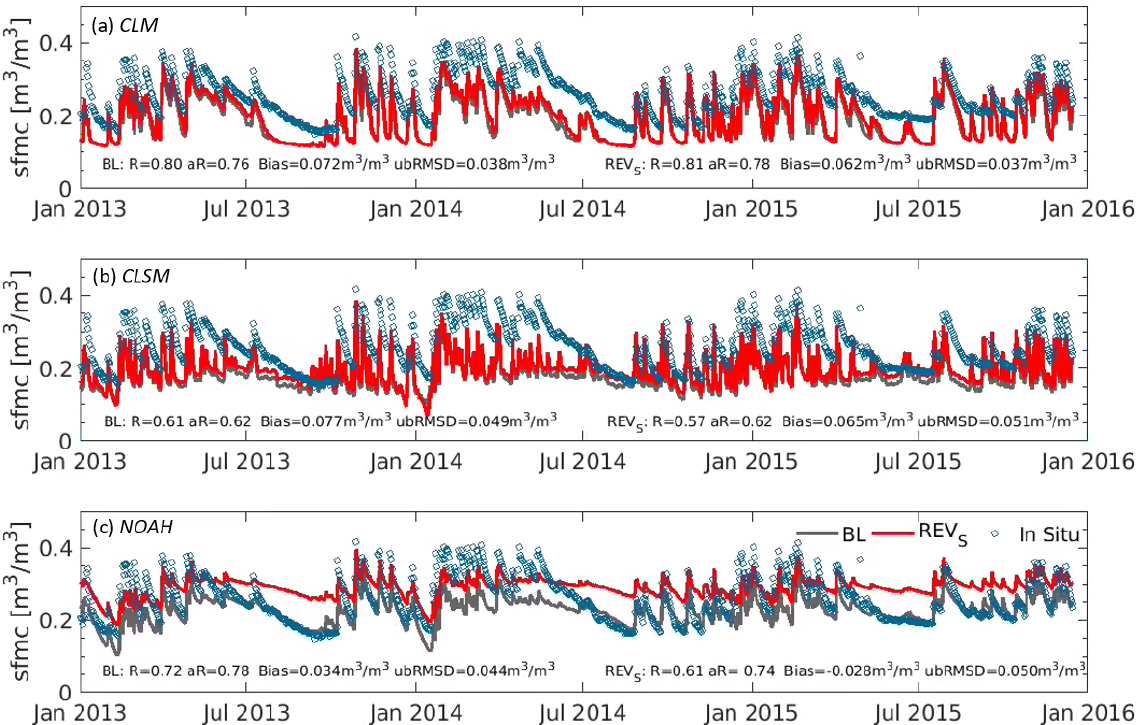
Figure 10. Simulated (BL and REV S ) and in situ observed surface soil moisture (sfmc) time series at Monte Buey, Argentina (32.91 ◦ S, 62.44 ◦ W), for the period January 2013–December 2015, for (a–c) CLM, CLSM and NOAH,